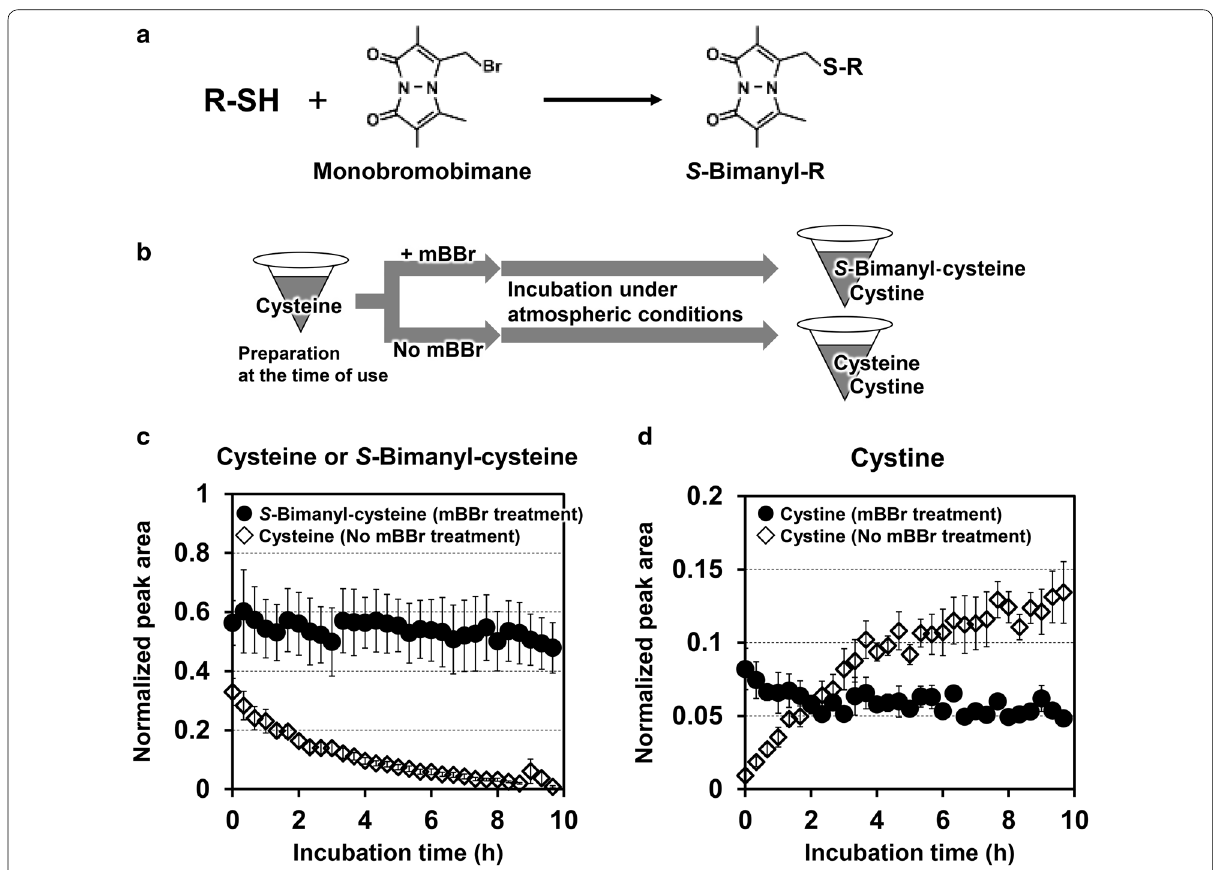
Fig. 1 Spontaneous chemical conversion of cysteine by reacting with atmospheric oxygen to produce cystine and effect to avoid the conversion by the treatment of chemical derivatization of thiol group of cysteine utilizing monobromobimane. a Reaction of thiol molecule and monobromobimane. b Schematic representation of the experimental procedures. Briefly, cysteine aqueous solution prepared at the time of use was immediately treated by adding mBBr solution (denoted as “ mBBr”) or only its solvent (denoted as “No mBBr”). The solutions were incubated + under atmospheric conditions and then intermittently subjected to the measurement by LC–MS/MS analysis (see “Materials and methods”). c Time course of cysteine-bimane content in “mBBr treatment” solution (closed circle) and cysteine content in “No mBBr treatment” solution (open diamond). d Time course of cystine content in “mBBr treatment” solution (closed circle) and “No mBBr treatment” solution (open diamond). The contents were determined as the peak area in mass chromatogram monitoring m/z characteristic of individual target compounds, and are represented as the normalized peak area after normalization with that of internal standard. Data values are